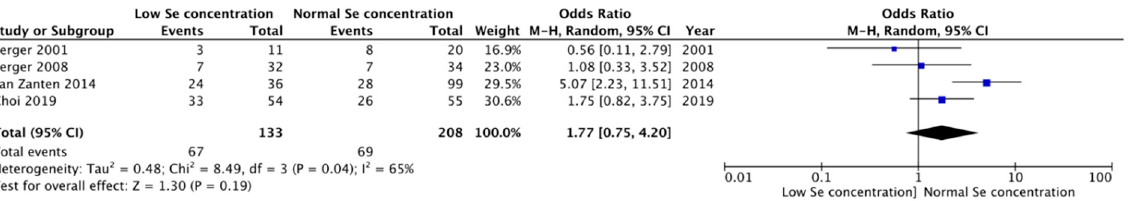
Figure 4. Forest plot of the impact of low serum Se concentration on the presence of pneumonia of in patients with severe trauma.